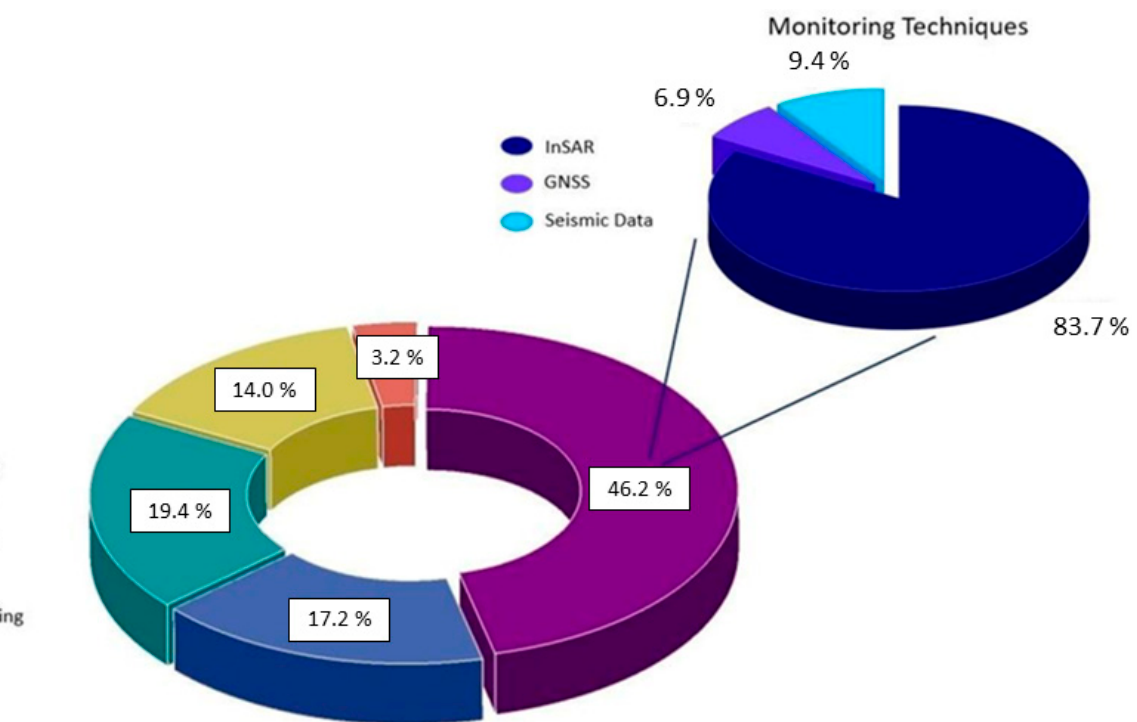
Figure 9. Statistical distribution of the research topics. In the top right: the percentage of main monitoring techniques used in data collection.